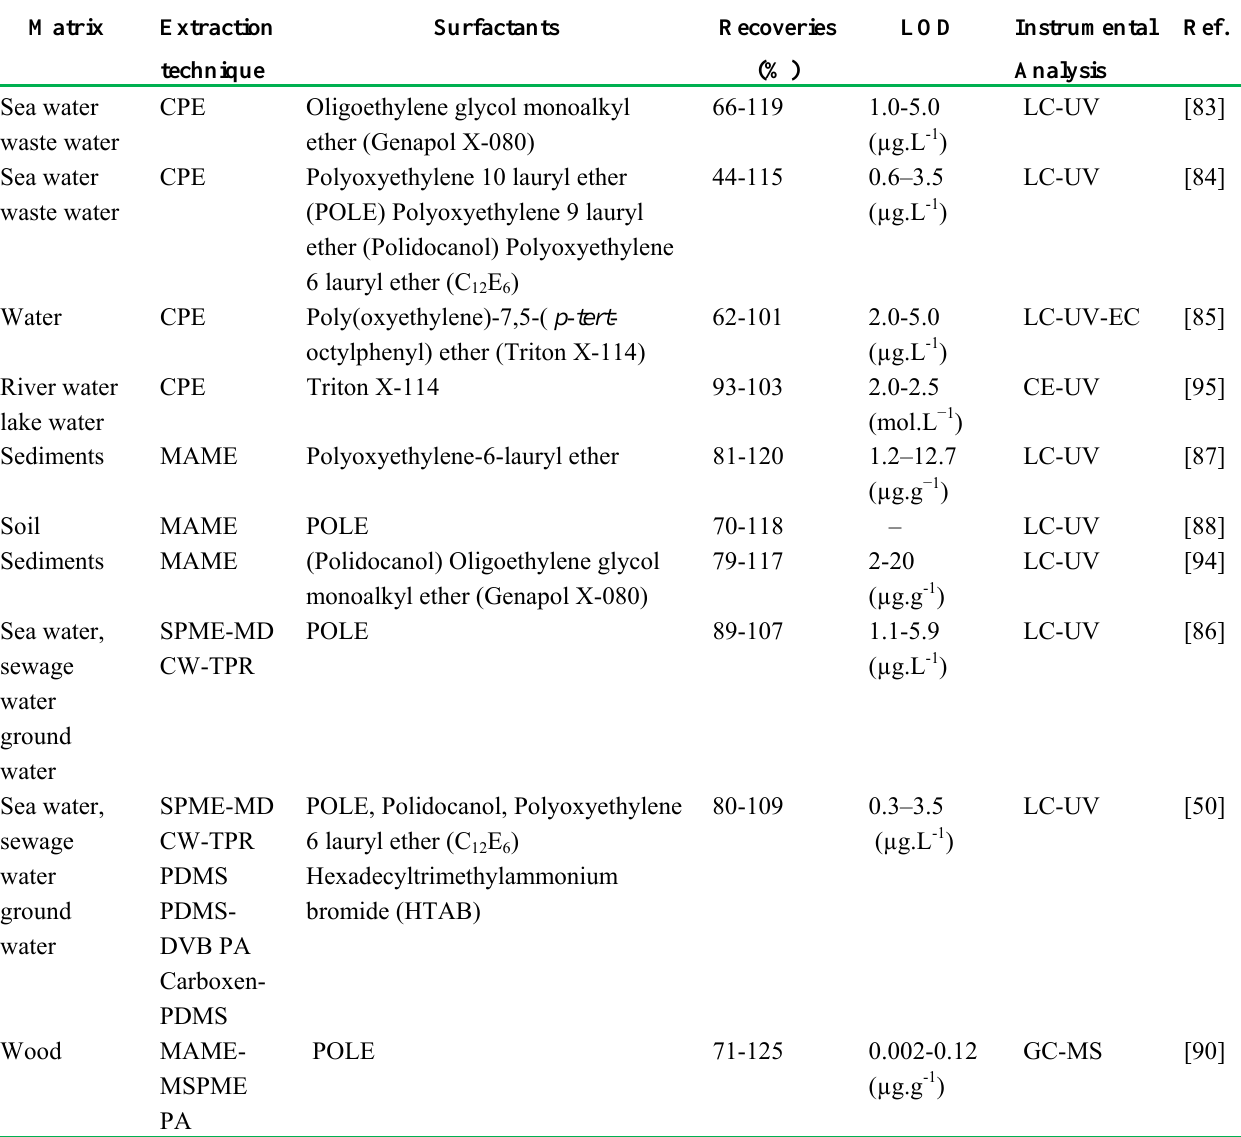
Table 3 . Methods for the determination of phenolic compounds using surfactant